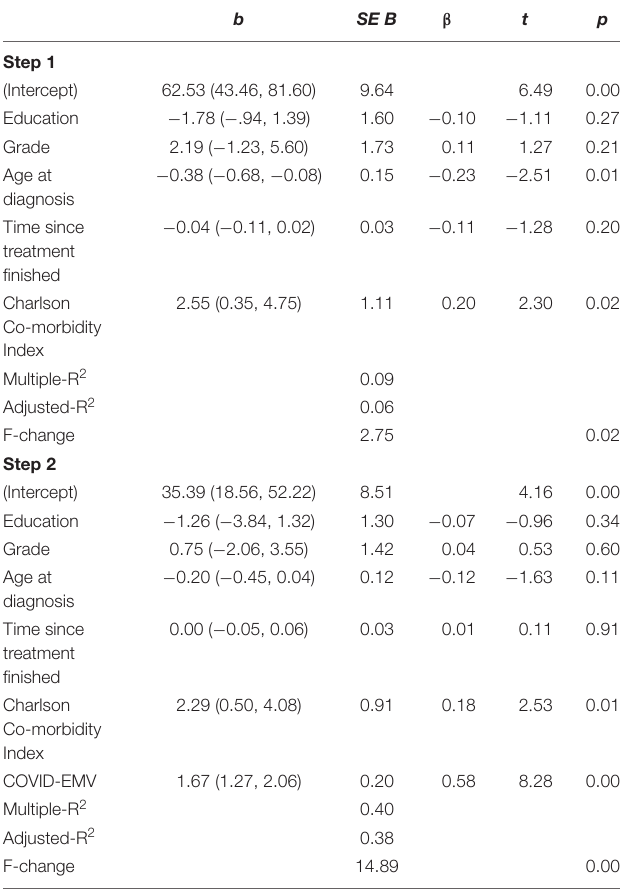
TABLE 3 | Hierarchical regression analyses for the predictors of